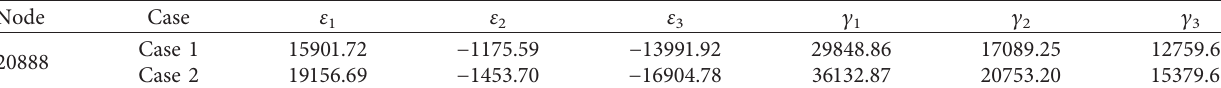
Table 7: Three principal strains and three local maximum shear strains at the critical point (unit: με ).